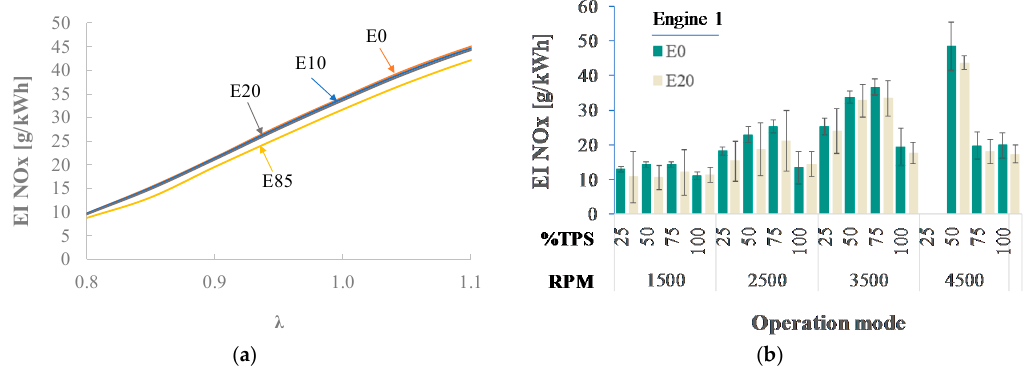
Figure 7. NOx emission indexes obtained by ( a ) Our analytical model for engines; and ( b ) Tests on engine 1 under steady-state conditions, when the engine used different ethanol-gasoline blends.